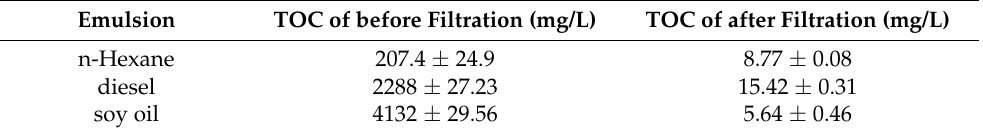
Figure 5. ( a ) Digital photos showing the emulsion separation process. ( b ) Optical microscopy images and photographs of the emulsions before and after separation (the scale bar is 50 μ m). ( c ) Permeation flux and the corresponding TOC content of the filtrates for various emulsions under the effect of gravity (no external driving force). ( d ) Permeation flux and the corresponding TOC contents of the filtrates from the separation process of soy oil emulsion using different membranes at different driving pressures. Table 1. The TOC content of the filtrates for various emulsions under the effect of gravity (no external driving force) using H-PDA.